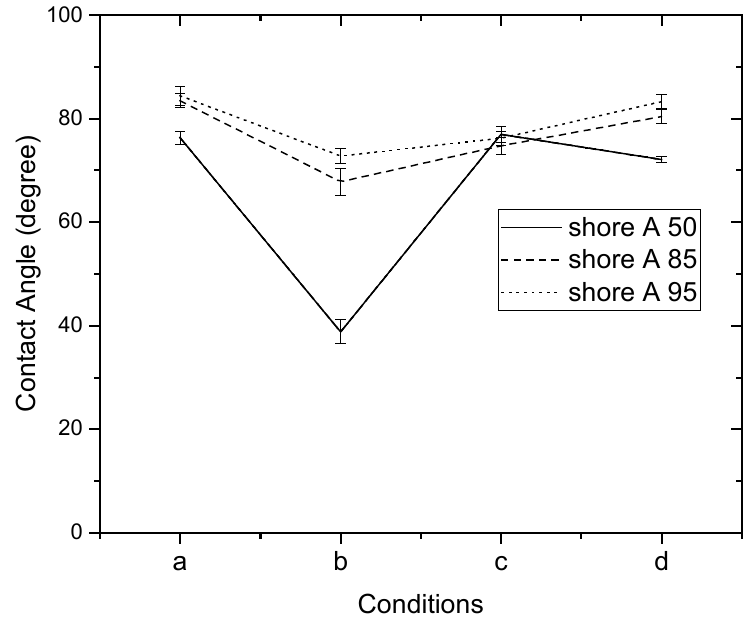
Figure 5. Contact angles of distilled water on Parylene C coated on substrates with different Shore A hardness values: (a) unsoaked, (b) soaked in 10% sodium hydroxide, (c) soaked in 10% ammonium hydroxide, and (d) soaked in 100% phosphate-buffered saline.